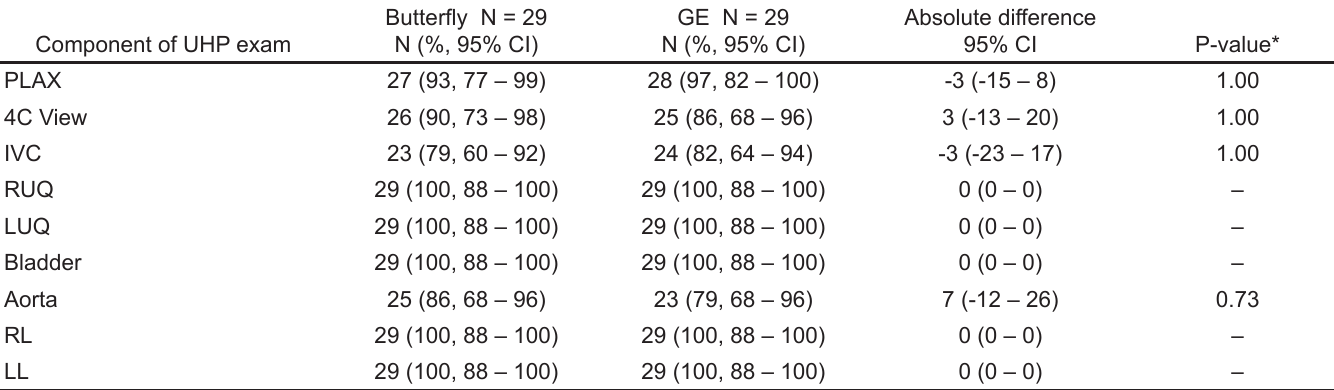
Table 2. Number of diagnostic-quality images, handheld Butterfly vs cart-based GE ultrasound